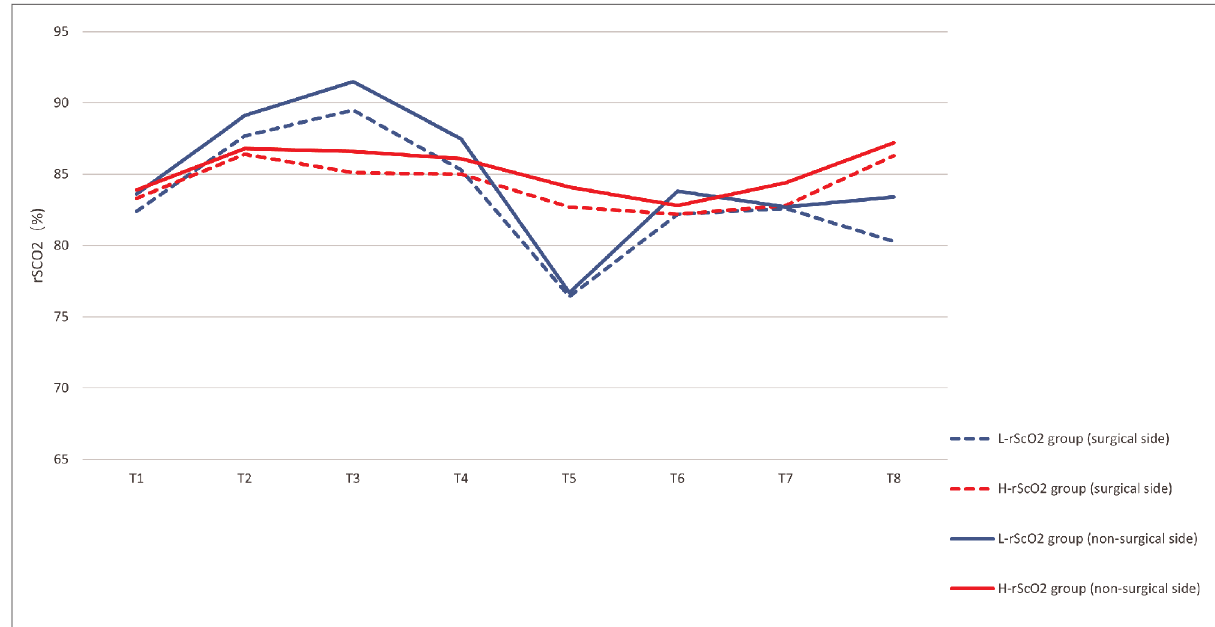
FIGURE 2 Comparison of intraoperative rSCO2 at each time